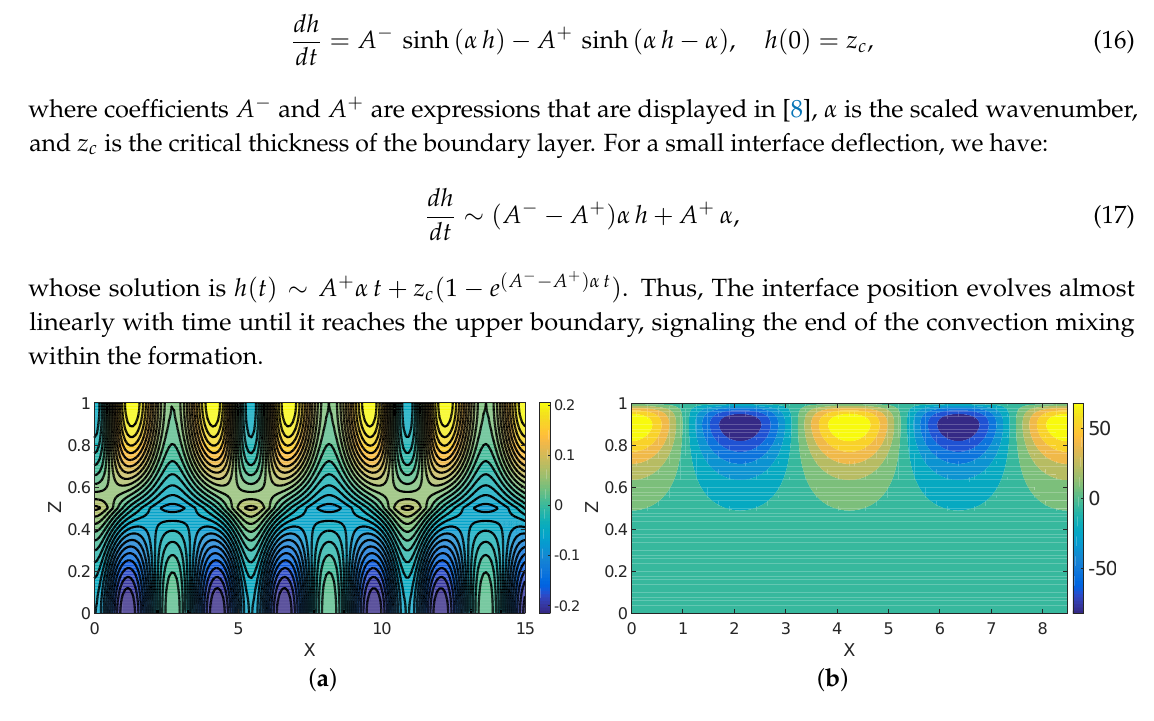
Figure 5. Plot of the concentration as function of the deviation from onset of convection, namely c = c 0 + (cid:101) 2 c 2 where (cid:101) denotes the amplitude of motion and c i are the O ( i ) contributions to the concentration. A large deviation leads to the appearance of finger morphology ( a ) [7]. Plot of the streamlines for parameter values, ξ = 1, Da = 0 and (cid:96) = 2 ( b ) [8]. As the permeability contrast between the top and bottom regions increases, high intensity convection gets confined at the top and penetrates the bottom regions, thus inducing only a low-intensity convective flow there. Reproduced with permission from